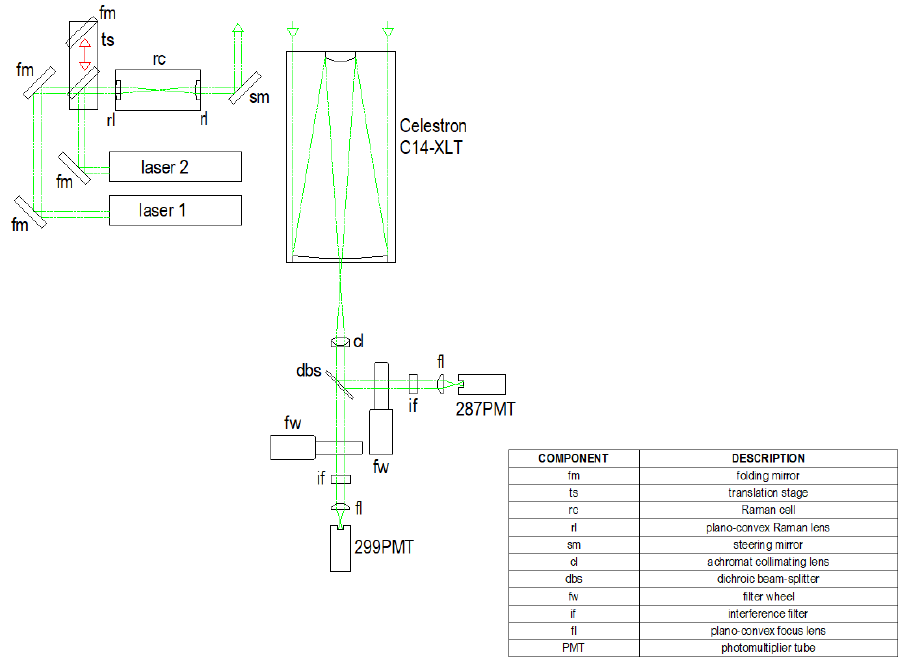
Figure 3. A schematic showing the transmitter and receiver design for the DIAL ozone system. The abbreviations are explained in a separate box in the figure. Note the translation stage that can be moved to change which laser is